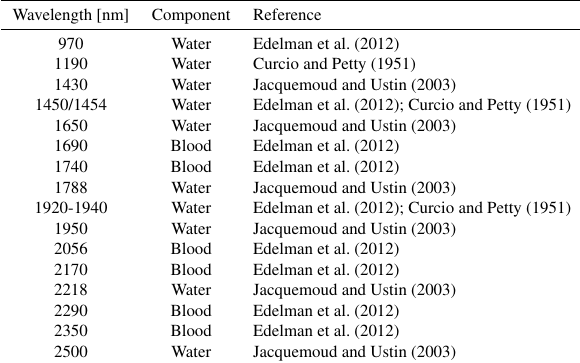
Table 2: List of spectral peaks, in range of SWIR, of several trace components as reported in the literature. The component blood comprises hemoglobin, albumin, and globulin.